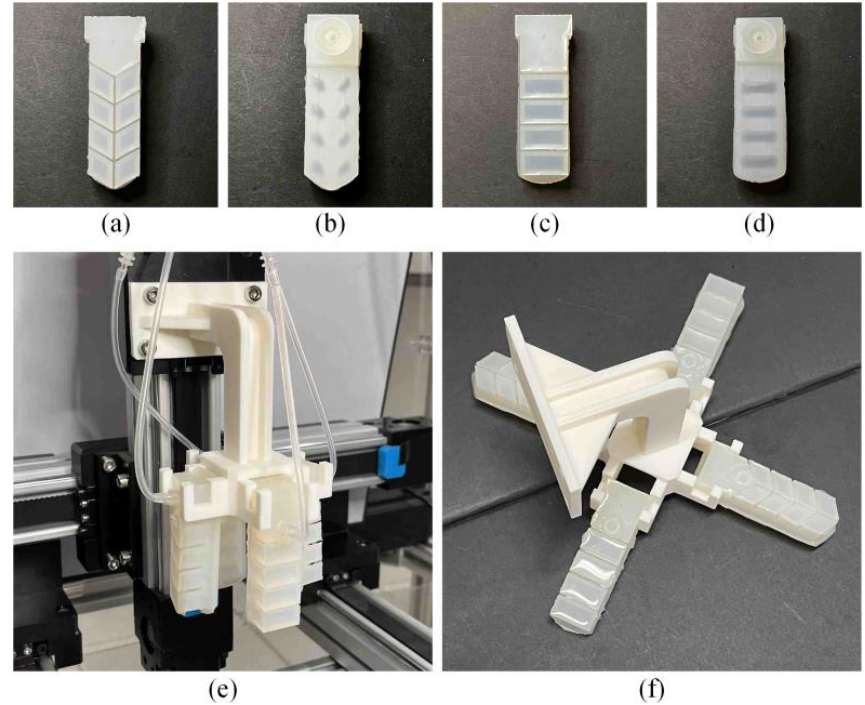
Figure 2. The prototype actuators and modular soft gripper. ( a ) Top and ( b ) bottom views of the herringbone actuator. ( c ) Top and ( d ) bottom views of the regular actuator. ( e ) The modular gripper with the actuators assembled ( e ) vertically and ( f ) horizontally.